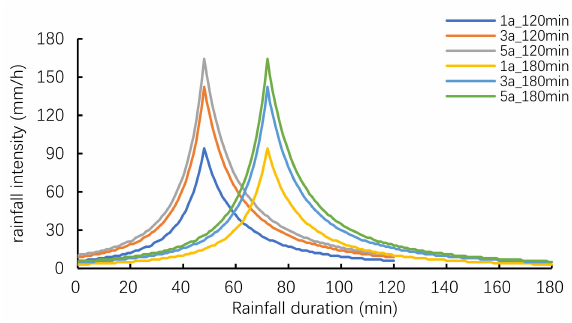
Figure 2. Duration curve of storm intensity.